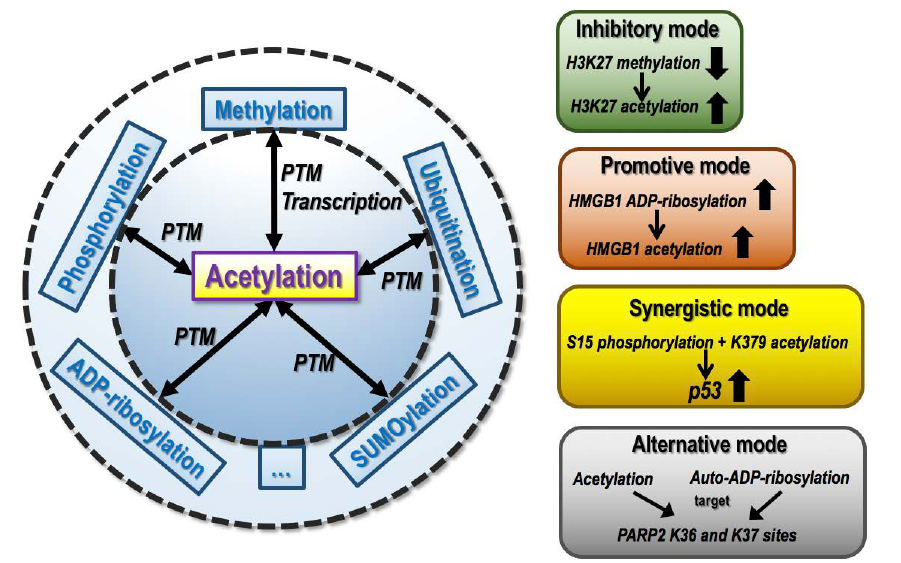
Figure 4. Crosstalk of lysine acetylation with other epigenetic events. Lysine acetylation develops crosstalk with other epigenetic events including, e.g., methylation (occurring at both transcriptional and PTM levels), and PTM events such as phosphorylation, ubiquitination, SUMOylation, and ADP-ribosylation to collectively regulate the levels and functionalities of genes involved in cancer hallmarks. There exist at least four modes among these crosstalks including the ‘inhibitory mode’, ‘promotional mode’, ‘synergistic mode’, ‘alternative mode’. An example of the ‘inhibitory mode’ is that reduced H3K27 methylation could lead to enhanced H3K27 acetylation. As an example of the ‘promotional mode’, ADP-ribosylation of HMGB1 could elevate its acetylation. An example of the ‘synergistic mode’ is that both S15 phosphorylation and K379 acetylation of p53 could lead to its enhanced expression. As an example of the ‘alternative mode’, the K36 and K37 of PARP2 are target sites of both acetylation and